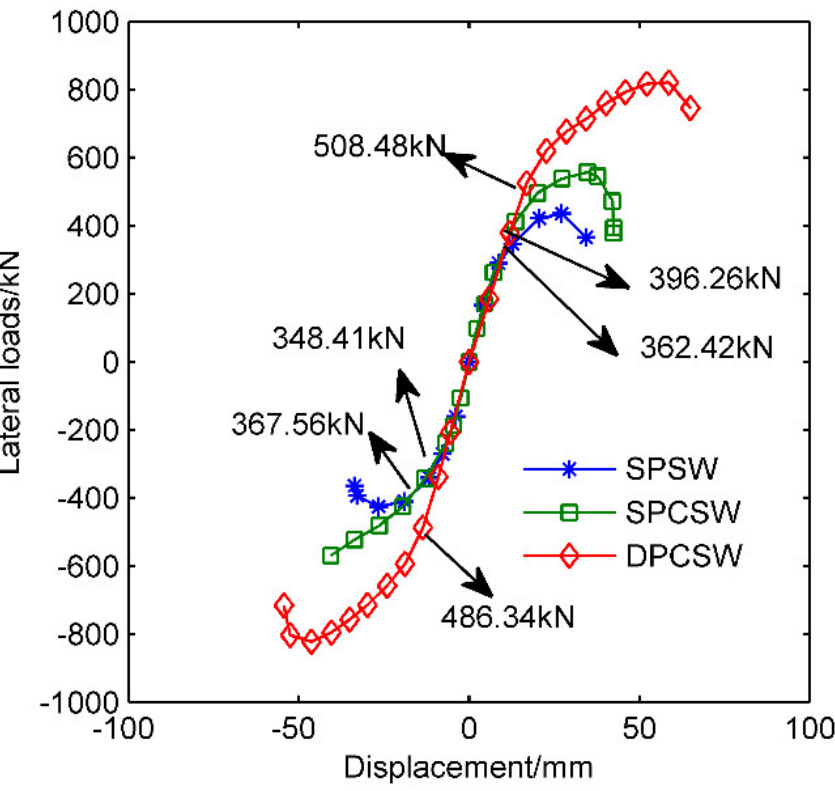
Figure 12. Skeleton curves of different specimens.